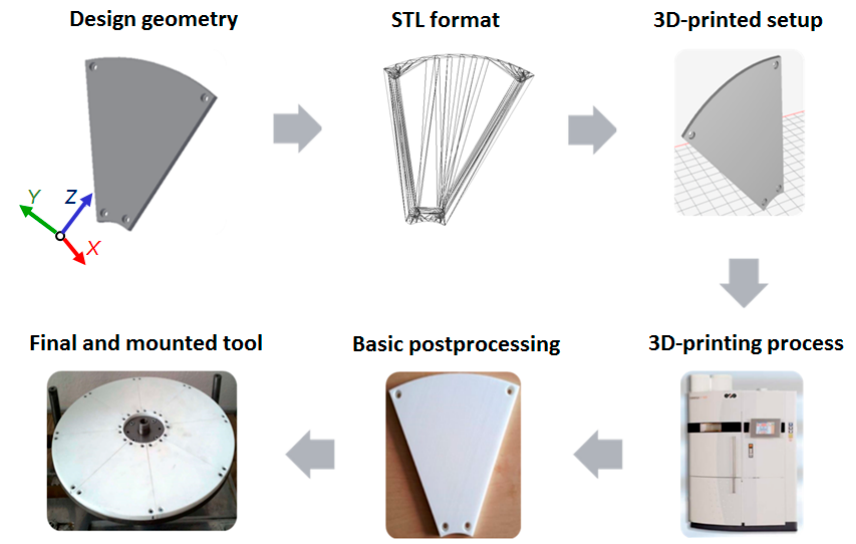
Figure 1. The 3D printing process chain of the SLS-lapping plate.